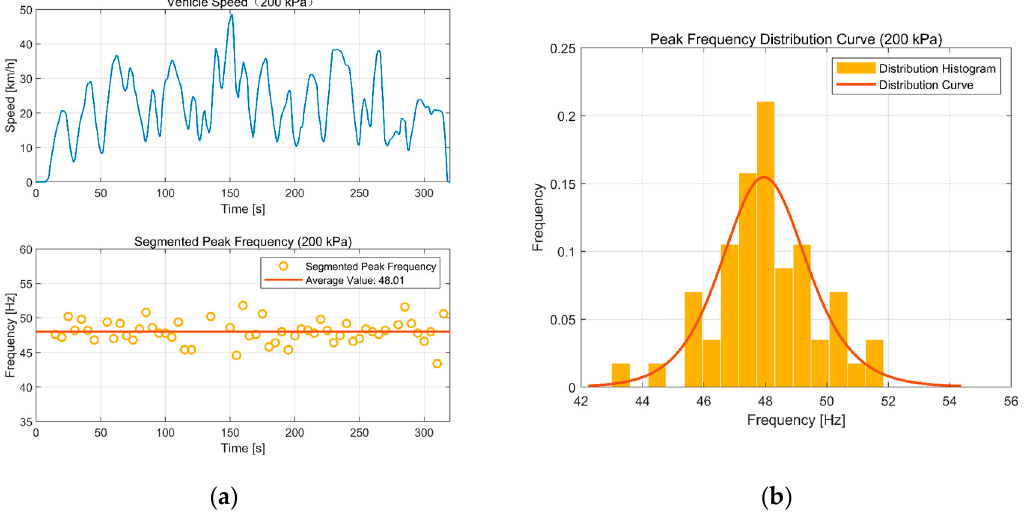
Figure 12. Result at 200 kPa: ( a ) Peak-frequency extraction; ( b ) peak frequency distribution curve.